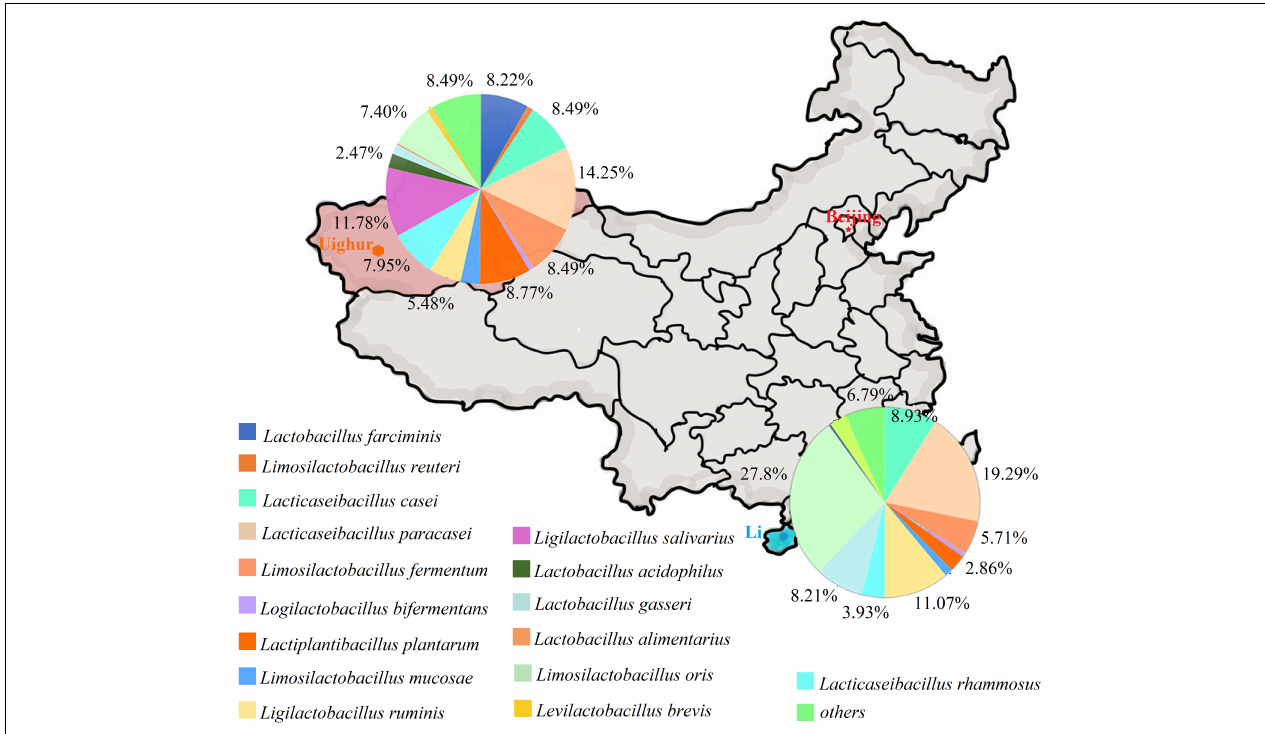
FIGURE 1 | The composition of Lactobacillus from mother and infant between Uighur and Li based on culture method. Lactobacillus were identified by groEL gene sequencing.